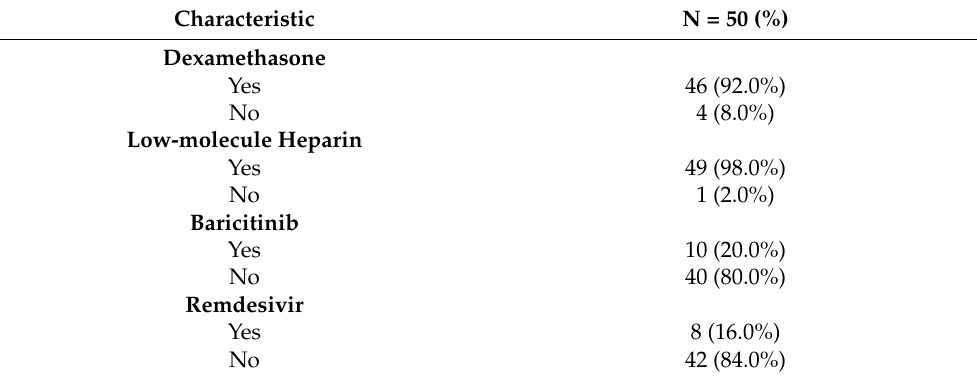
Table 6. Data on medications administered during